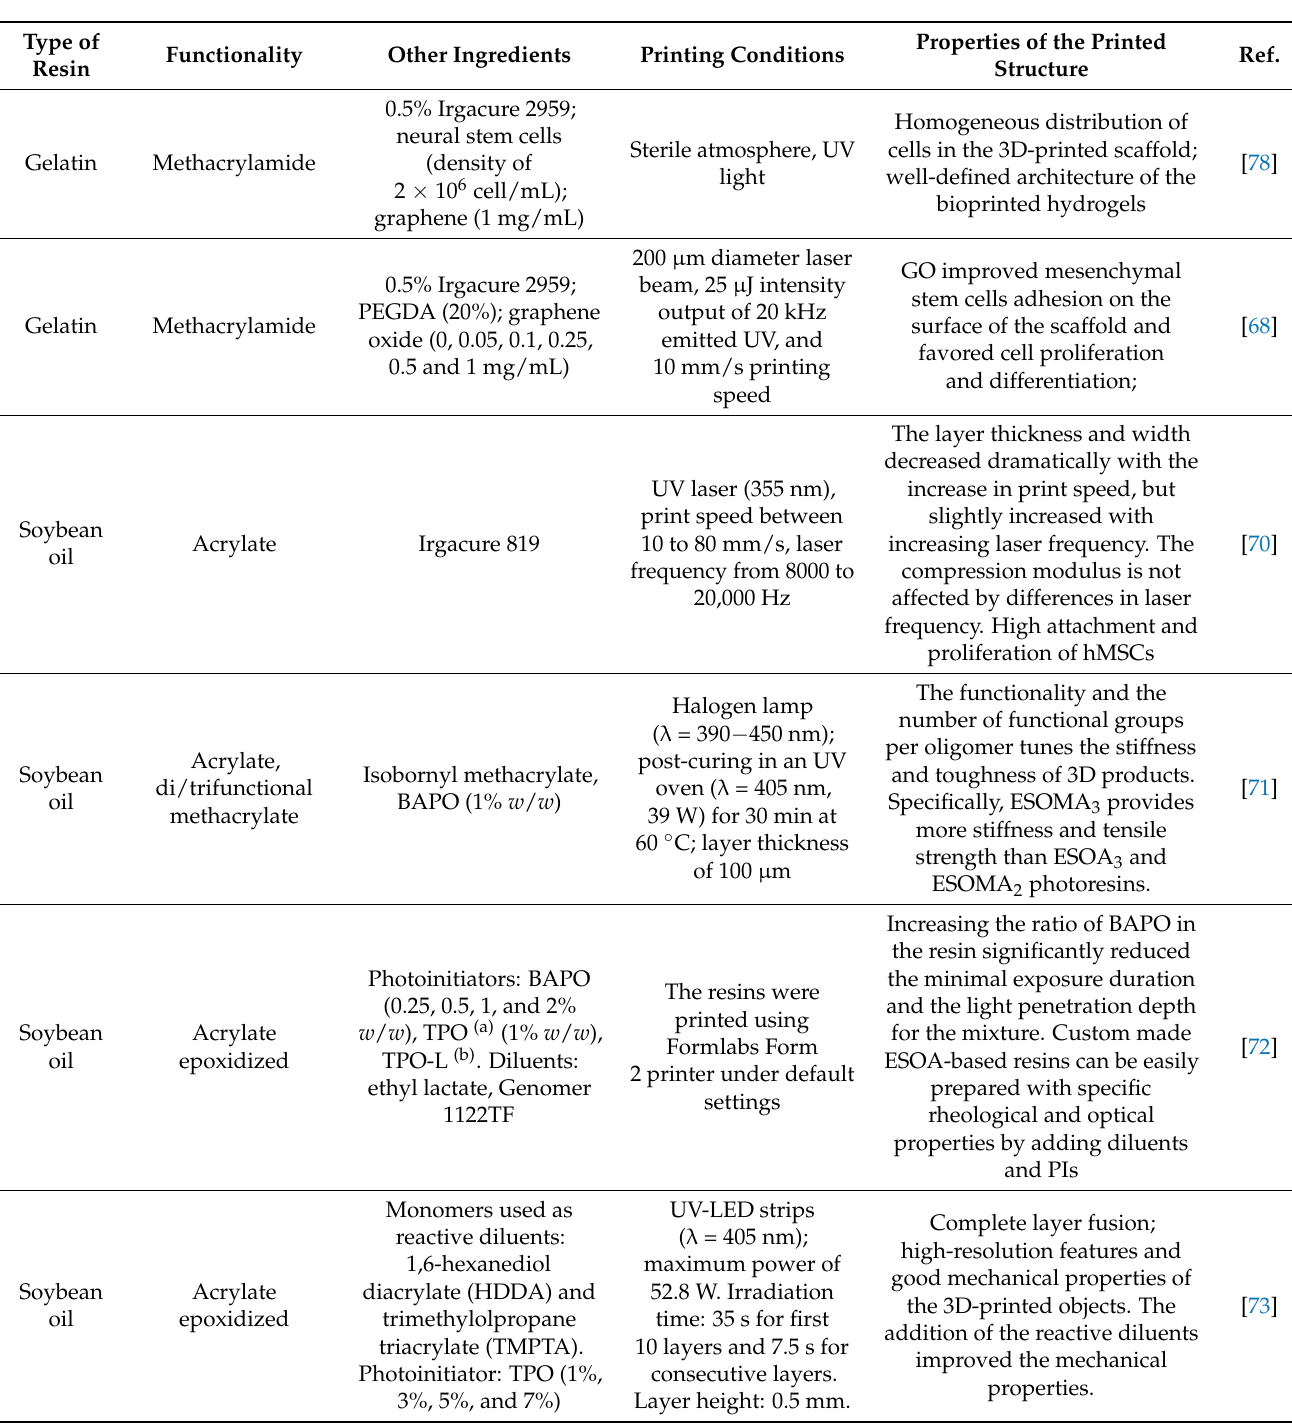
Table 1. The representative resin for SLA 3D printing, suitable for biomedical